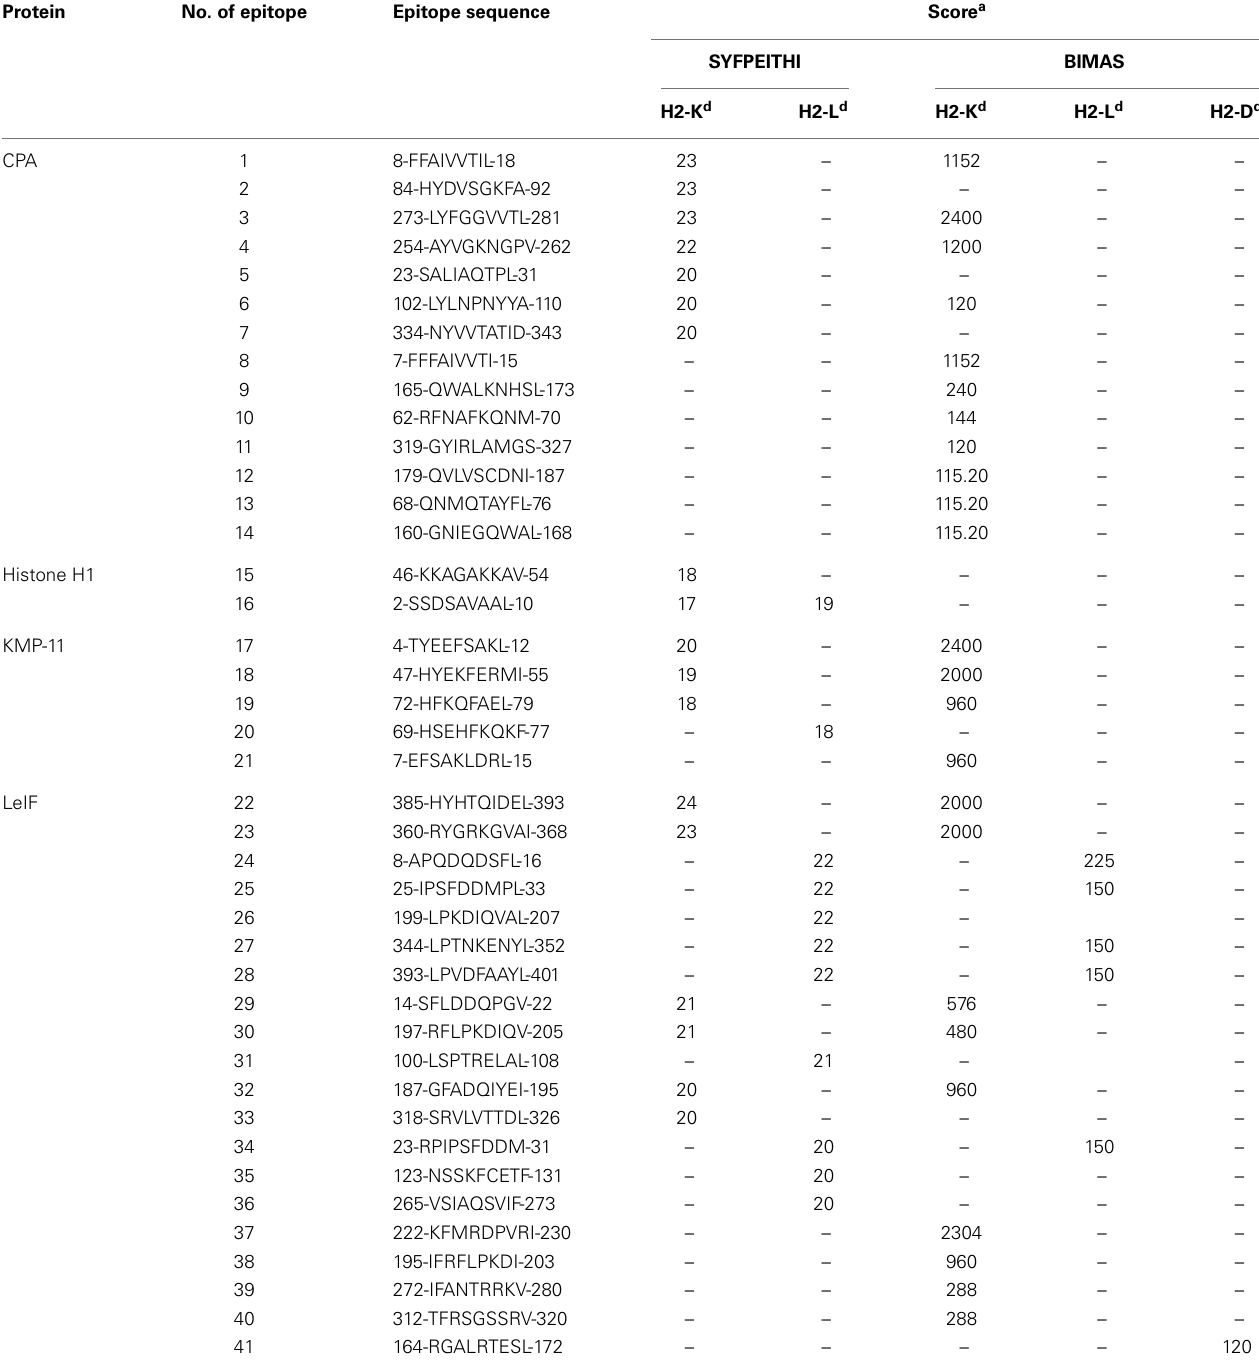
Table 2 | In silico predicted MHC class I-restricted 9-mer epitopes of L. infantum proteins . Protein No. of epitope